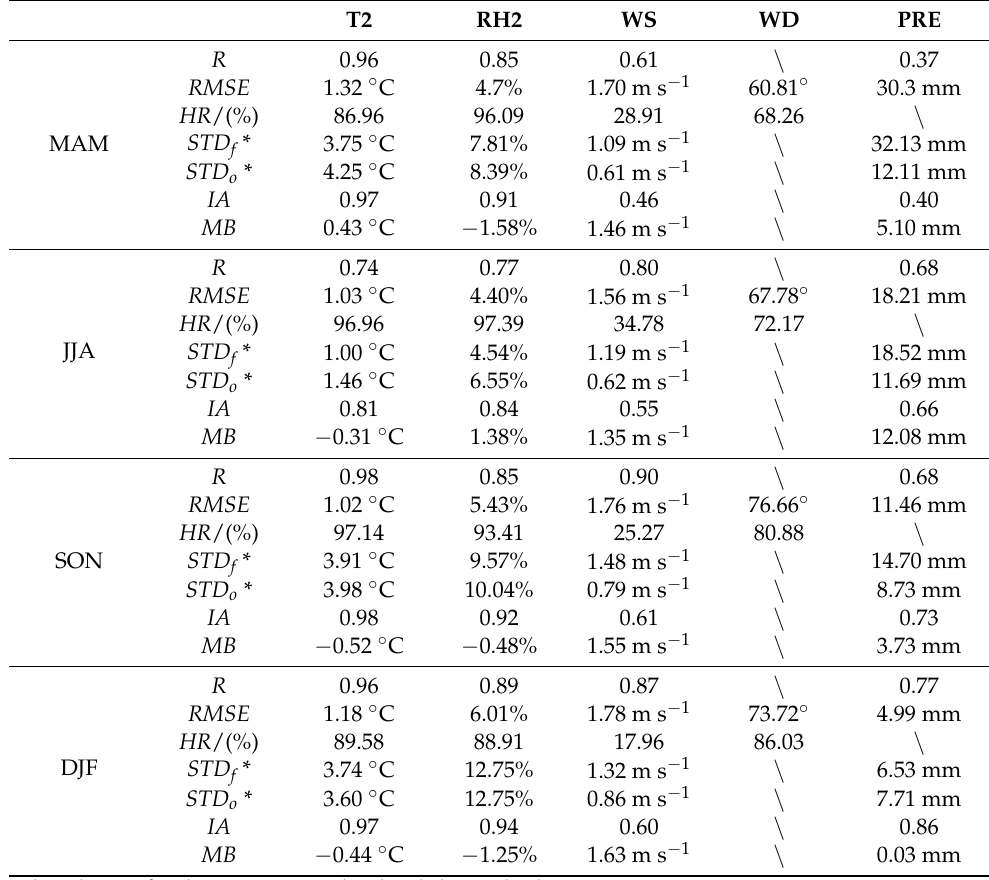
Table 6. Statistical indices for simulated and observed daily averaged T2, RH2, WS, WD, and PRE during different